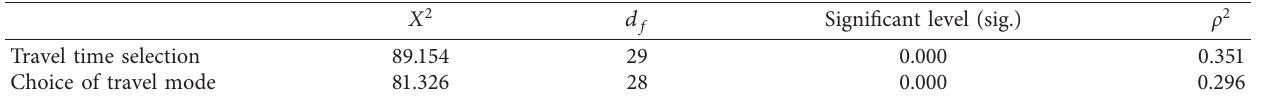
Table 6: Model likelihood ratio